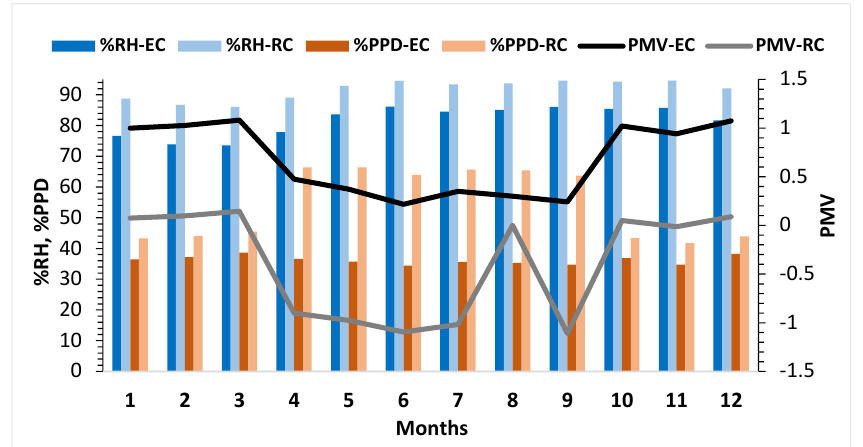
Figure 11. Relative humidity (%RH) predicted percentage of dissatisfied (%PPD) and predicted mean vote (PMV) monthly averages for EC and RC.